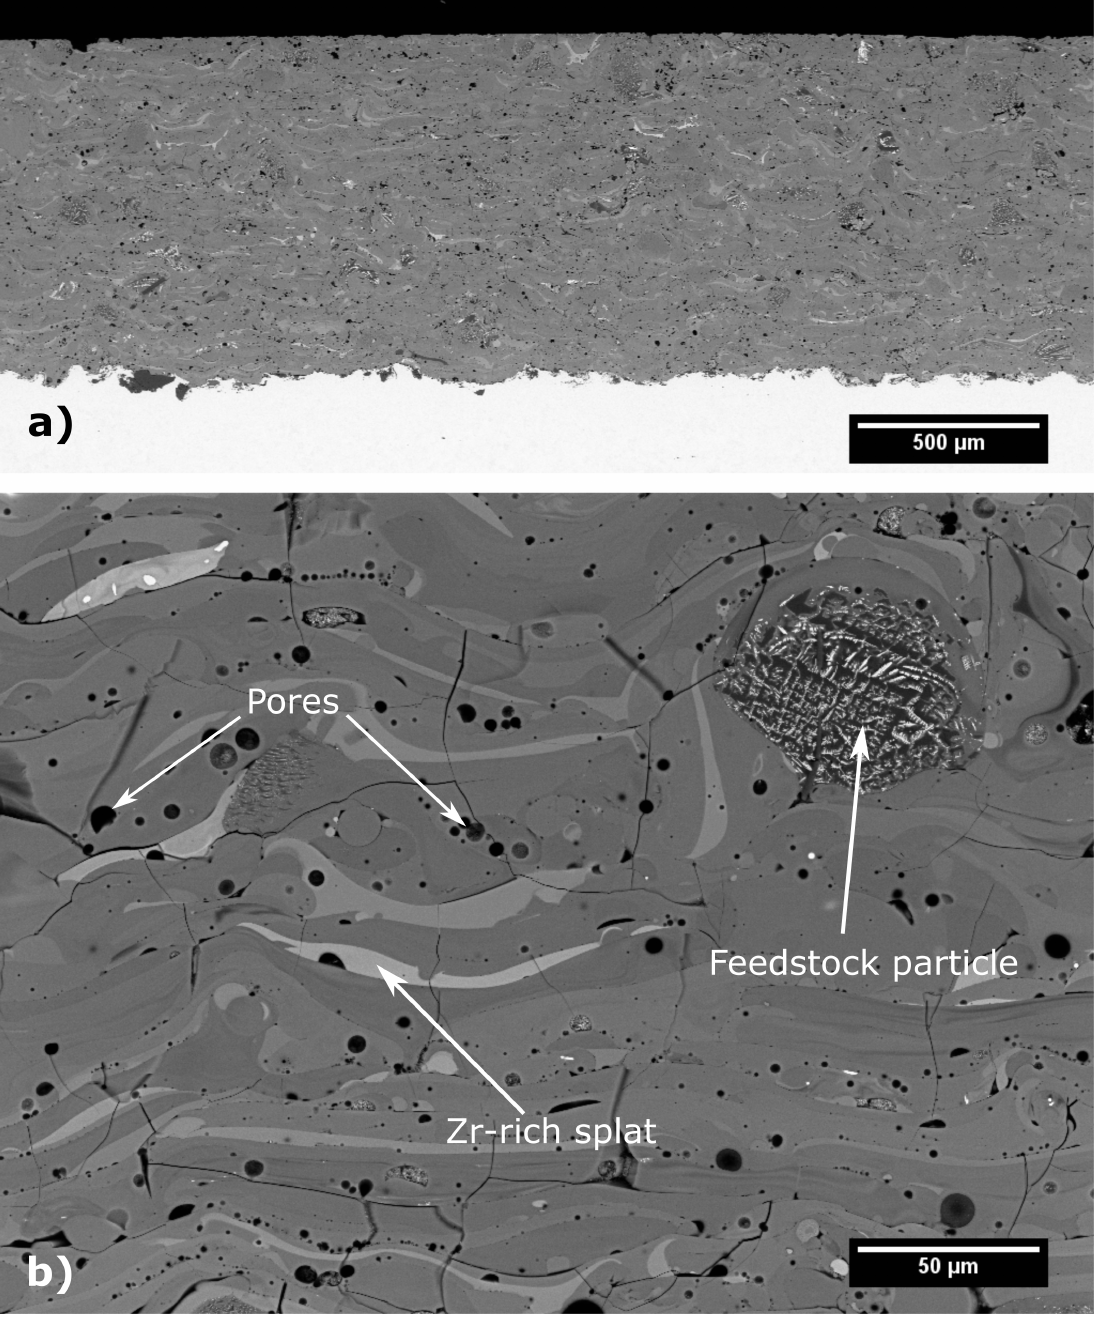
Figure 2. Microstructure of as-sprayed Al 2 O 3 –ZrO 2 –SiO 2 coating cross-section: ( a ) coating overview; ( b ) magnified view.